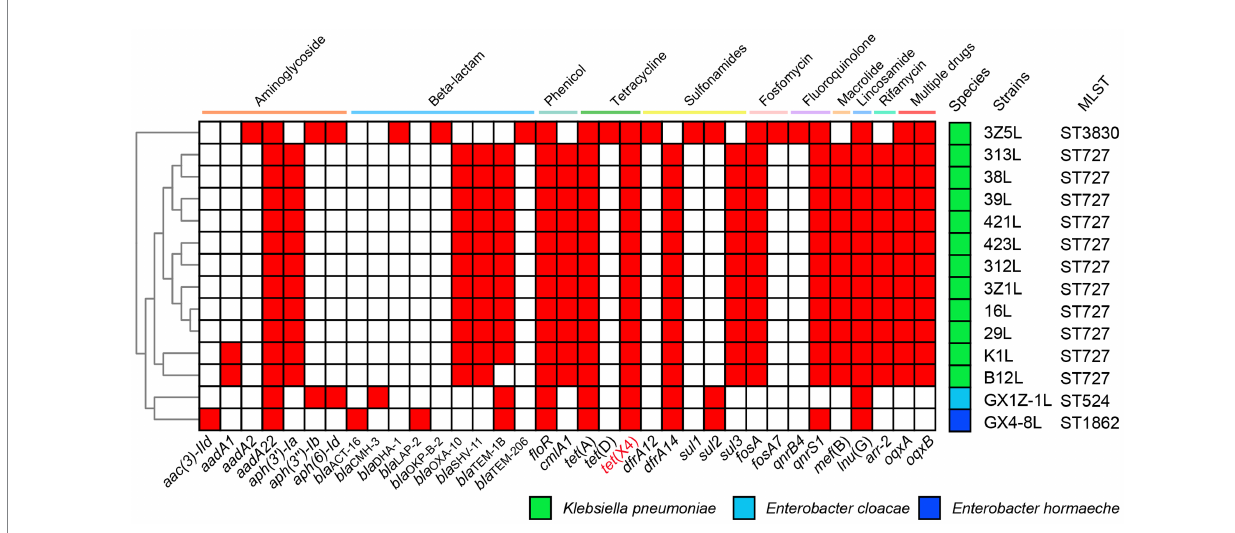
FIGURE 1 The heat map of antimicrobial resistance genes of 14 strains in this study. The positive genes in strains are marked with the red box. The names of genes are labeled below the heat